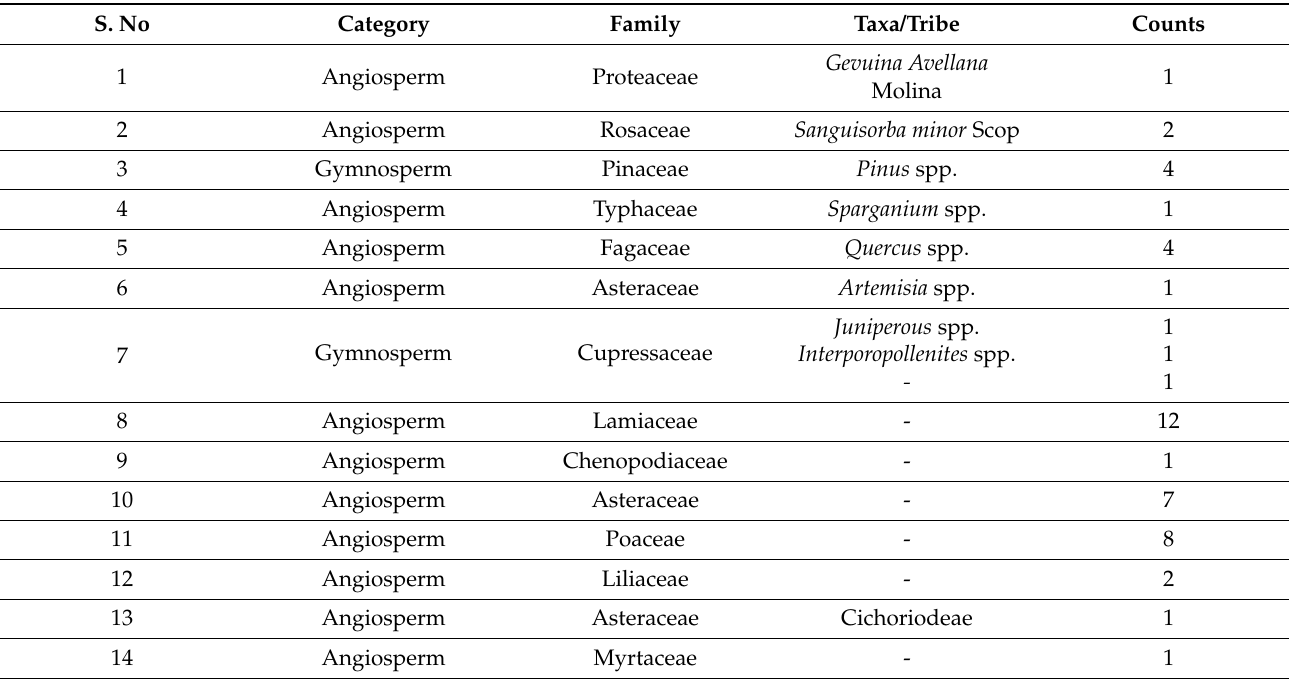
Table 3. Pollen category, families, taxa, and their